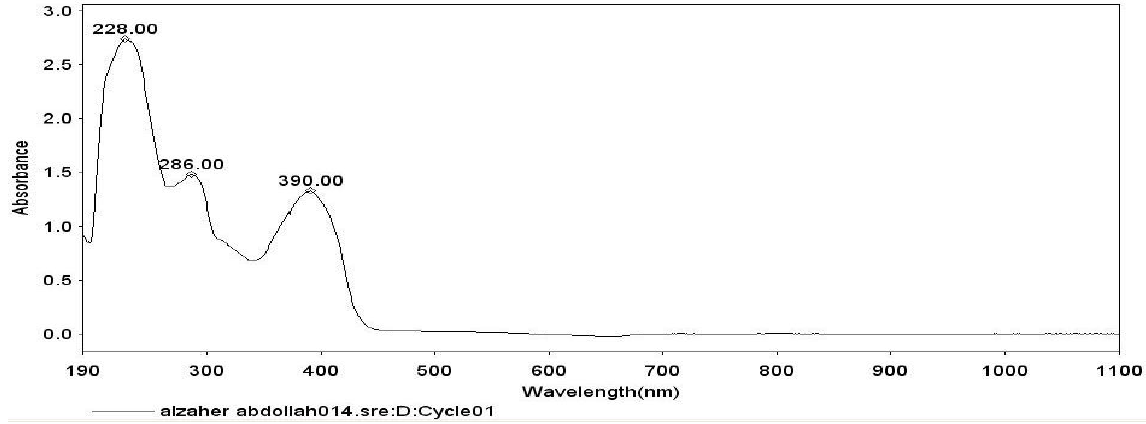
Figure 10. The ʎmax spectrum for Papaverrubine C compound.